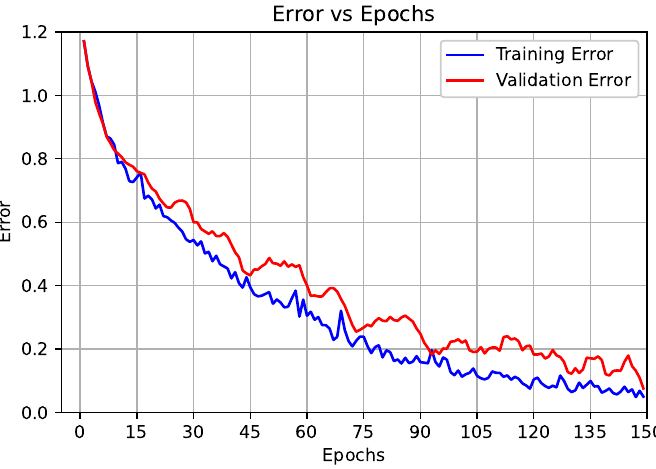
Figure 6. Proposed end-to-end CNN training and validation error curve.